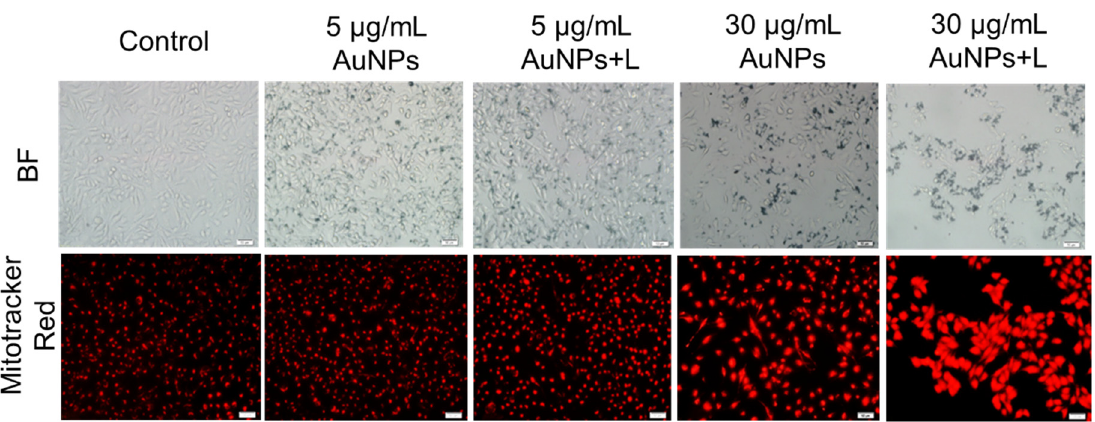
Figure 6. Morphology of mitochondria in MDA-MB-231 cells upon exposure to HA-capped AuNPs (with/without NIR lighting) at different Au concentrations, according to a Mitotracker Red staining assay. Scale bar represents 50 μ m.